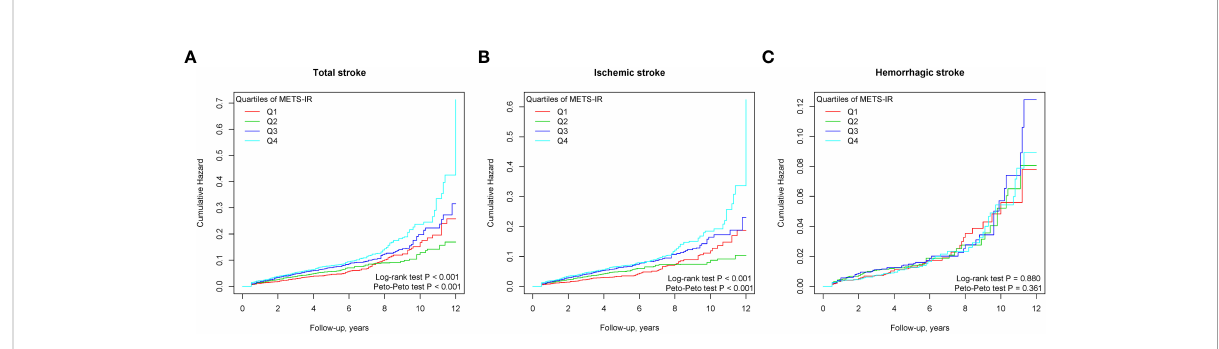
FIGURE 2 Cumulative incidence of outcomes strati fi ed by the quartile of the METS-IR. (A) total stroke; (B) ischemic stroke; (C) hemorrhagic